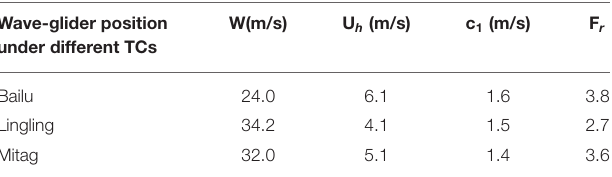
TABLE 1 | Wind speed, W , translation speed, U h , the first near-inertial oscillation speed, c 1 , and Froude number, F r , at the position of wave glider during TCs Bailu, Lingling, and